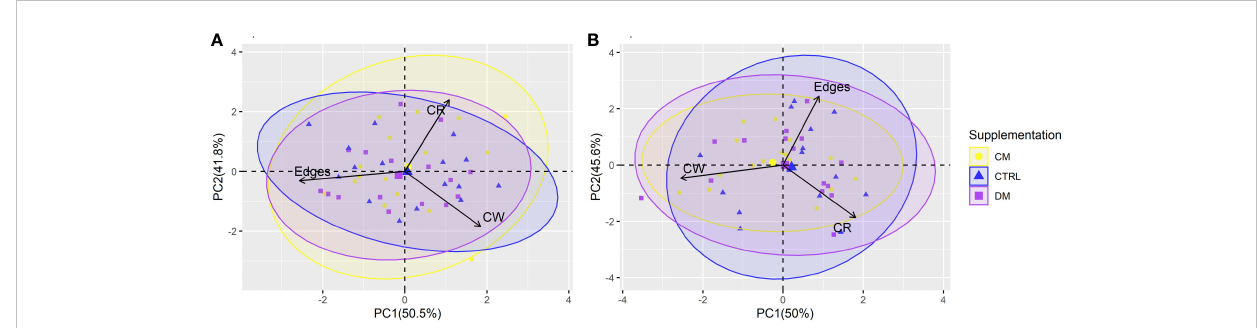
FIGURE 5 Principal component analysis (PCA) of the piglet ’ s behavior in the Open fi eld test before (A) and after (B) weaning (n = 48) submitted to three supplementations: DM (Asinine milk), CM (Cow skimmed milk) and CTRL (Control without supplementation). Behaviors: Edges (time in edges), CW